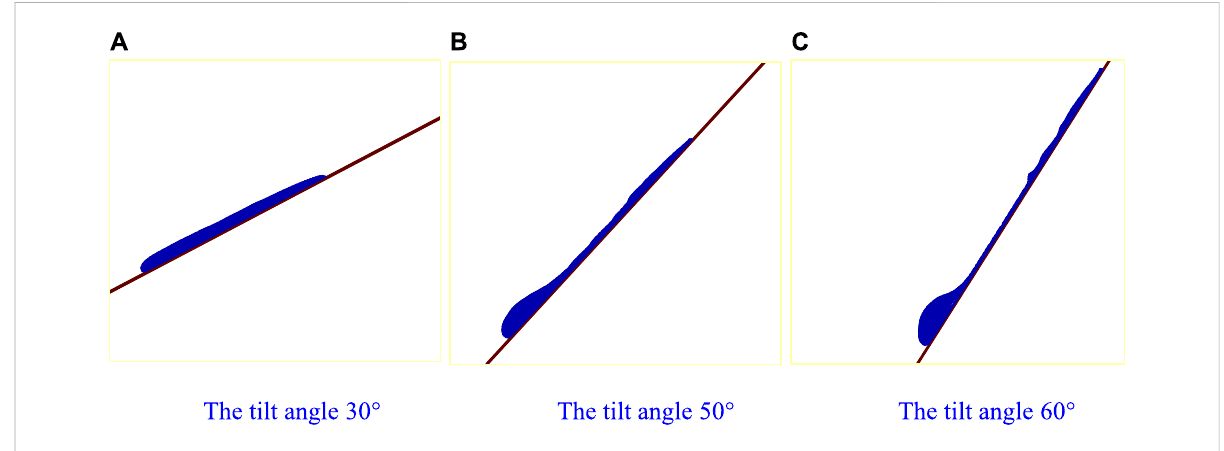
FIGURE 12 Bingham fl uid fl owonaslopeat t =8.5withtiltanglesof30 ° ,50 ° ,and60 ° . (A) Thetiltangleof30 ° . (B) Thetiltangleof50 ° . (C) Thetiltangleof60 ° .